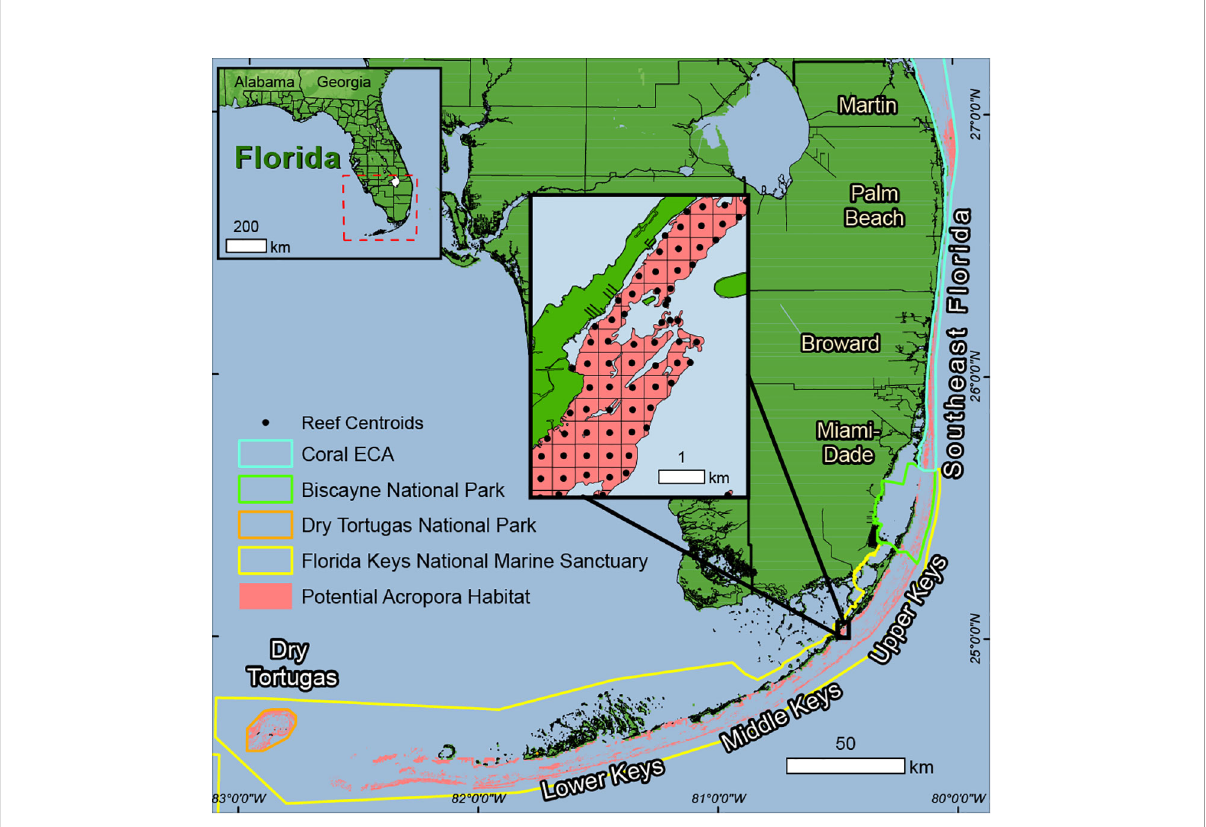
FIGURE 1 Map of Acropora habitat on Florida ’ s Coral Reef used from Wirt et al., 2015 in pink with the 500m grid and centroids to subdivide the habitat into relevant management units. Each grid square with its centroid is a reef, of which there 10277 in the dataset. The locations of the fi ve regions of the reef system are labelled, with the Dry Tortugas the most west, followed by the Lower Keys, Middle Keys, Upper Keys, and Southeast Florida the most